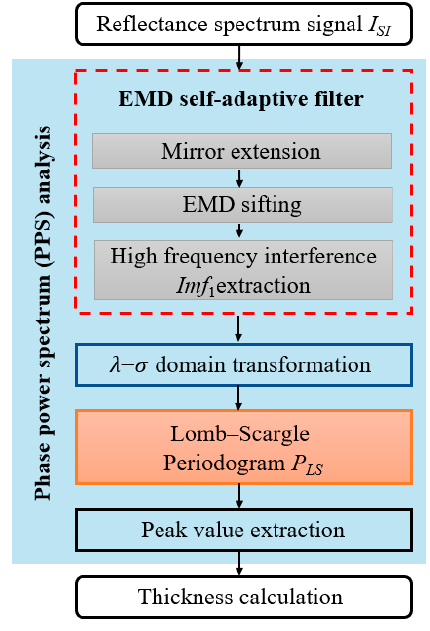
Figure 2. Flowchart of the proposed phase power spectrum (PPS) algorithm.